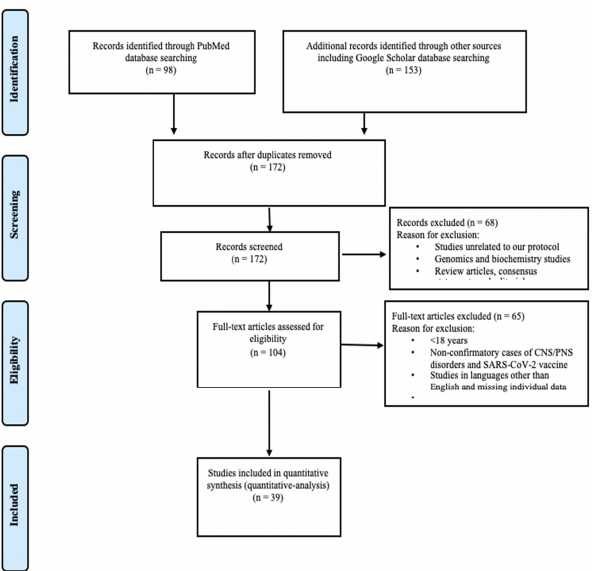
Figure 1. Preferred Reporting Items for Systematic Reviews and Meta-Analyses (PRISMA) Flow Diagram. 2.2. Inclusion Criteria The inclusion criteria for the published studies were: (1) patient age ≥ 18 years; (2) history of neurological adverse event(s) post-COVID-19 vaccination; (3) established neu- rological diagnosis in the patients with COVID-19 vaccination; (4) neuroimaging findings of CNS and PNS complications not accounted for by another neurological process. 2.3. Exclusion Criteria The exclusion criteria for the studies were: (1) duplicate studies that involved repeti- tion of cases; (2) studies in languages other than English; (3) studies with no individual data on and/or fatality of COVID-19 vaccination, and (4) studies with missing clinical in- formation. Cases were categorized into the following groups: (i) CNS inflammatory disorders including multiple sclerosis (MS)/MS exacerbation, acute disseminated encephalomyelitis (ADEM), transverse myelitis (TM), and neuromyelitis optica spectrum disorder (NMOSD); (ii) encephalitis and encephalopathy; (iii) GBS and its variants; (iv) Bell’s palsy; (v) ischemic disorders including ischemic stroke (both large and small vessel) associated with cerebral venous sinus thrombosis (CVST); and (vi) others, including small fiber neu-